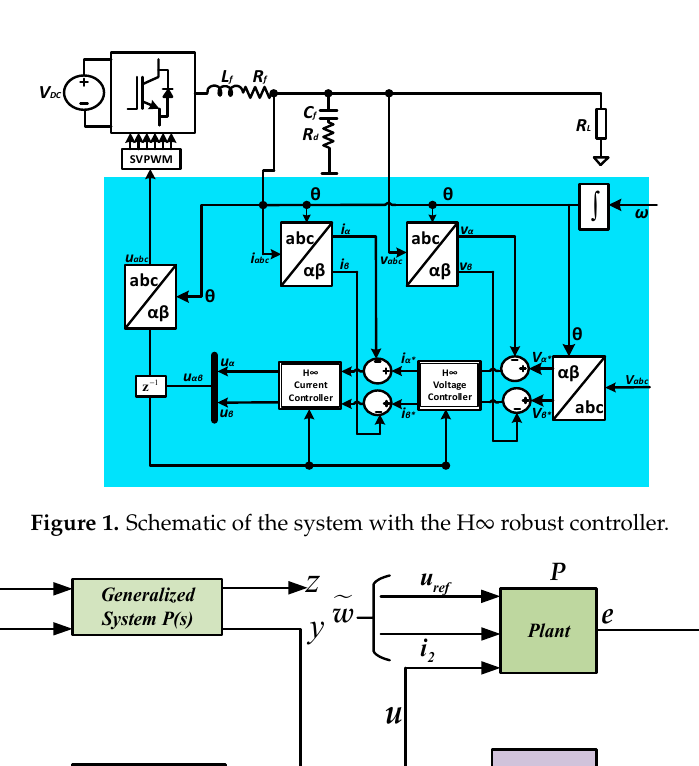
Figure 2. ( a ) Standard feedback robust control system, ( b ) Block diagram of the H ∞ robust voltage control scheme.